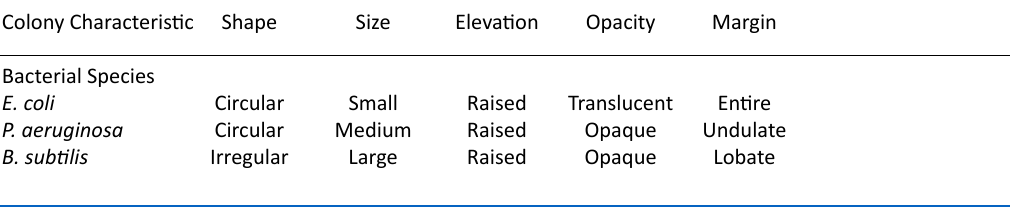
table 2. Colony characteristics of the isolated bacterial species Colony Characteristic Shape Size Elevation Opacity Margin Bacterial Species E. coli Circular Small Raised Translucent Entire P. aeruginosa Circular Medium Raised Opaque Undulate B. subtilis Irregular Large Raised Opaque